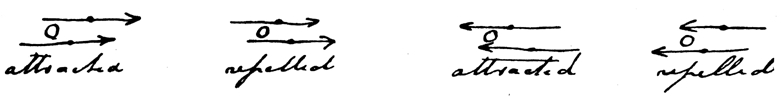
 The wire in Figure 2 viewed from above.